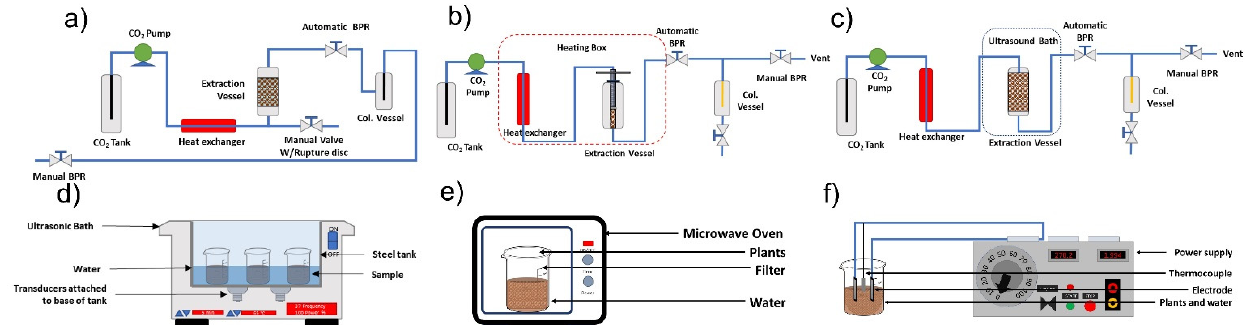
Figure 3. Organic extract extraction methods: ( a ) supercritical fluid extraction, ( b ) cold pressing-assisted supercritical fluid extraction, ( c ) ultrasound-assisted supercritical fluid extraction, ( d ) ultrasound-assisted extraction, ( e ) microwave-assisted extraction, and ( f ) ohmic heating-assisted extraction (Hatami et al. [20] and Fragoso-Jiménez et al. [51]).